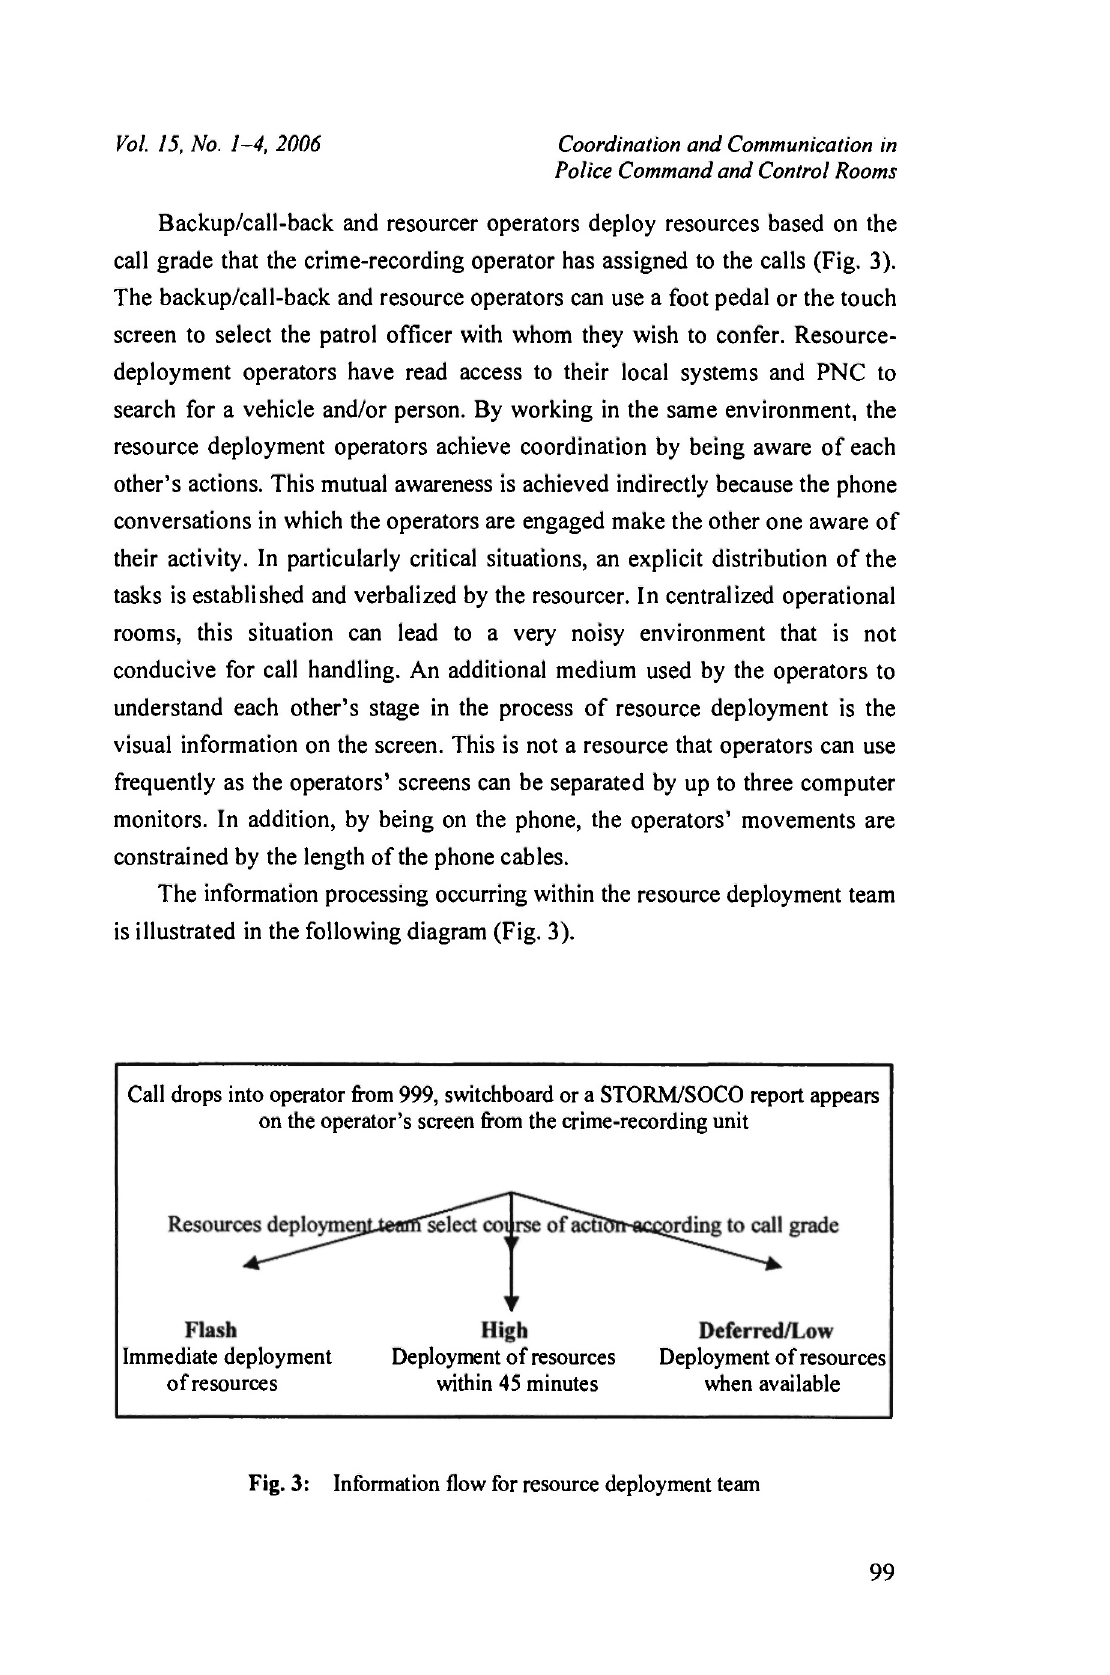
Fig. 3: Information flow for resource deployment